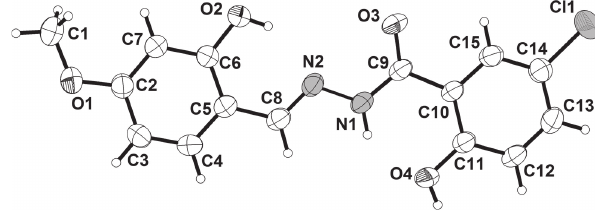
Table 1: Data collection and handling.